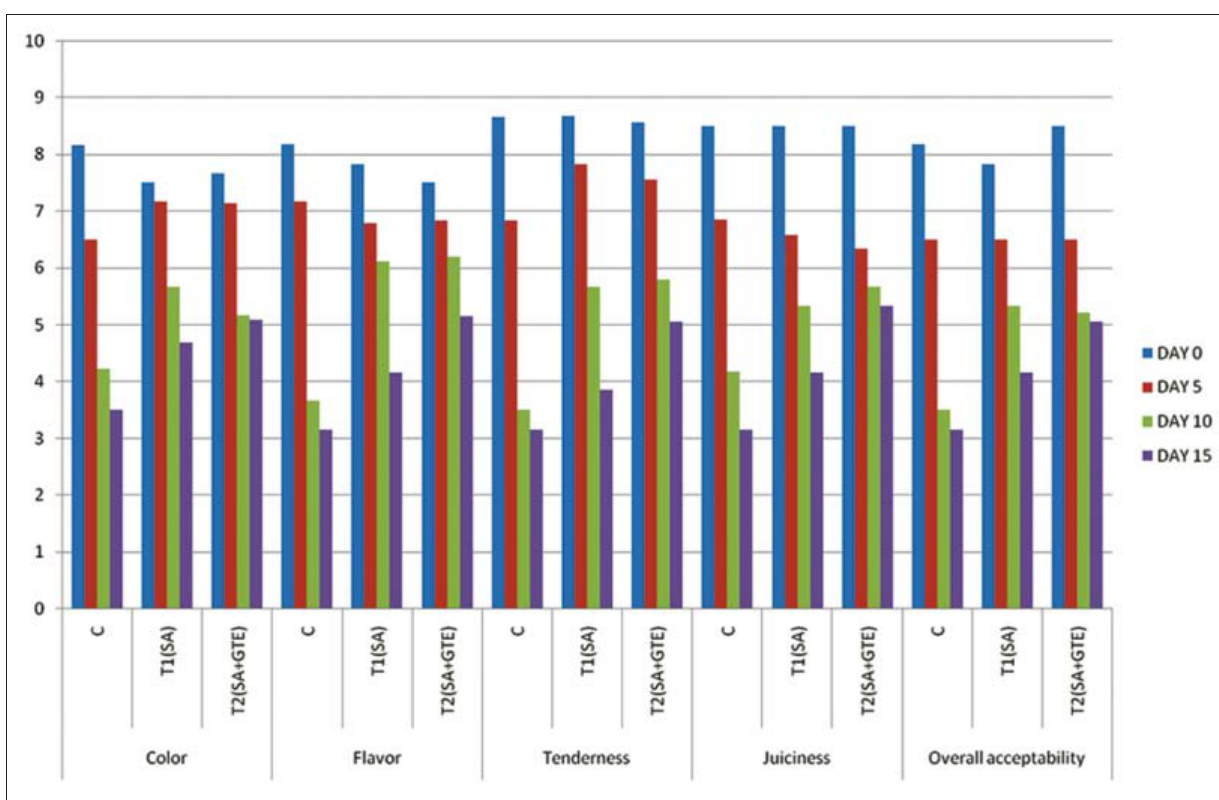
Figure-1: Sensory evaluation of chicken nuggets at refrigerated storage.